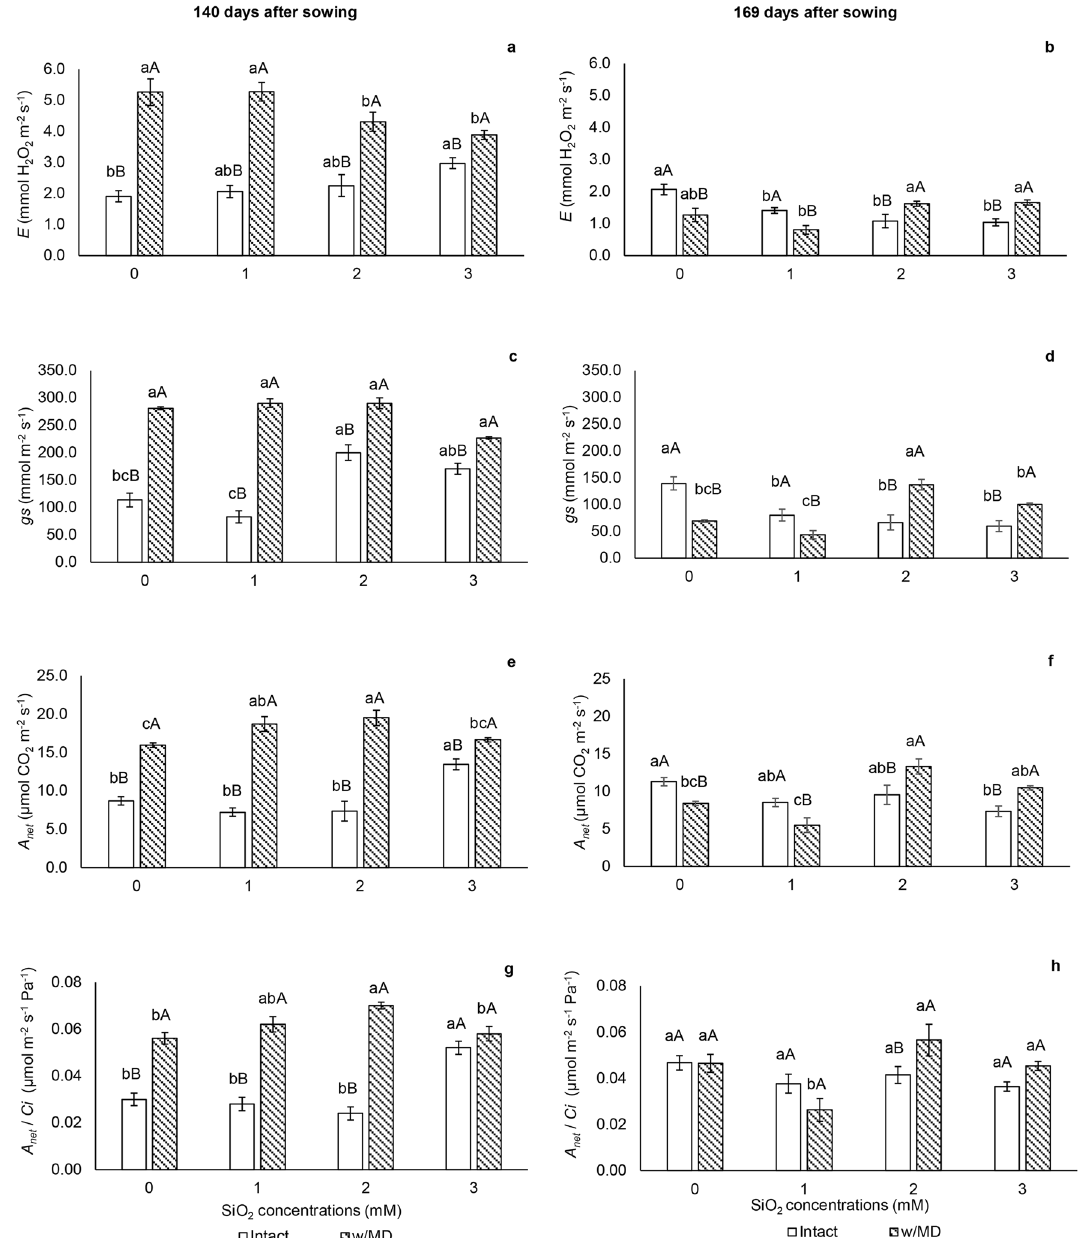
Figure 2. Gas exchange. ( a , b )Transpiration rate ( E, mmol H 2 O m −2 s −1 ) p < 0.01; ( c , d ) stomatal conductance ( g s , mmol m −2 s −1 ) p < 0.01; ( e , f ) CO 2 assimilation rate ( A net , μmol CO 2 m −2 s −1 ) p < 0.01; ( g , h ) RuBisCO carboxylation efficiency ( A net / C i , μmol m −2 s −1 Pa −1 ) p < 0.03 in Passiflora incarnata L. with mechanical damage (w/MD) and without mechanical damage (intact), subjected to SiO 2 variations at 140 and 169 days after sowing. Values corresponding to the averages ± SE. Capital letters compare plants with and without mechanical damage and lower letters compare SiO 2